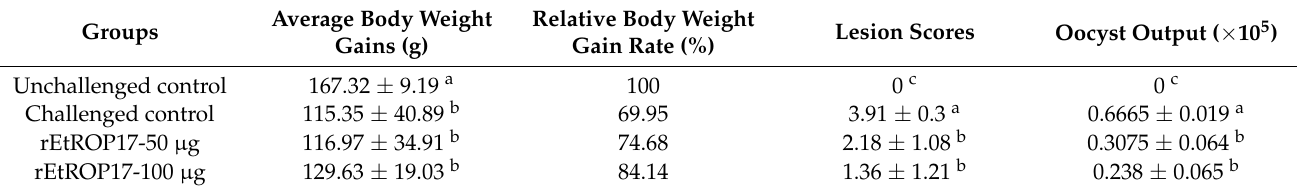
Figure 4. ( A ) IgY titers. ( B ) Relative body weight gain. ( C ) Cecal lesion scores. ( D ) Oocyst output. Bars sharing the same letters indicate no significant difference. Bars sharing the same letters indicate no significant difference. Table 2. Protective effects in each